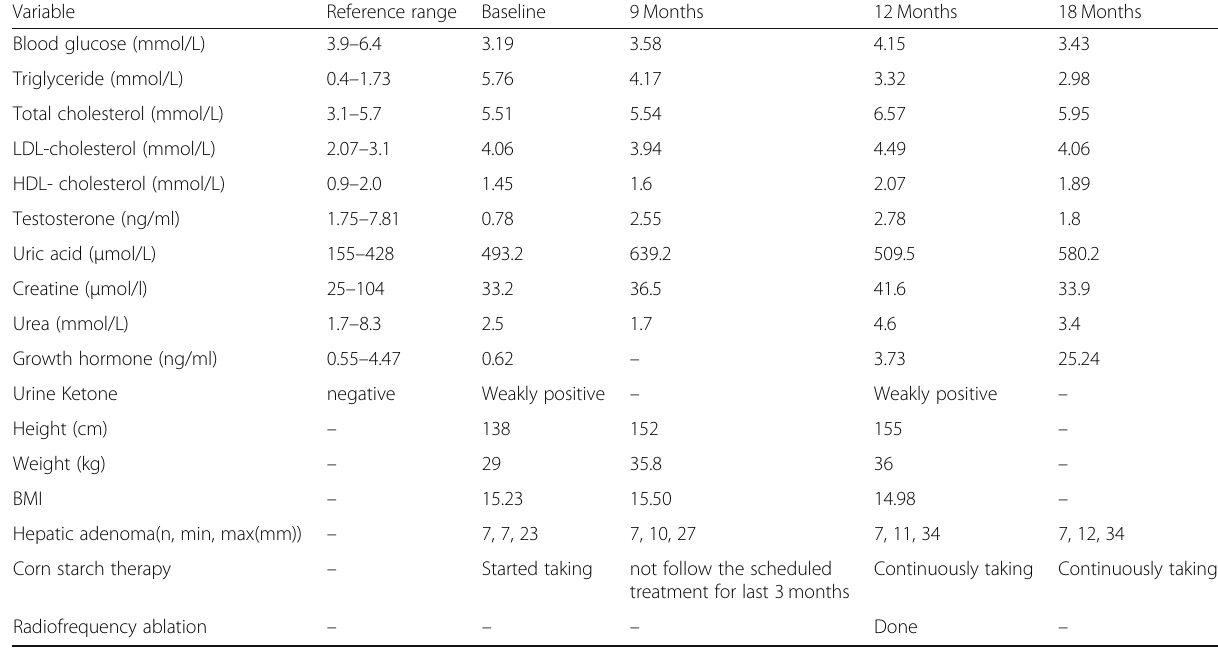
Table 2 Examination data on presentation and follow-up